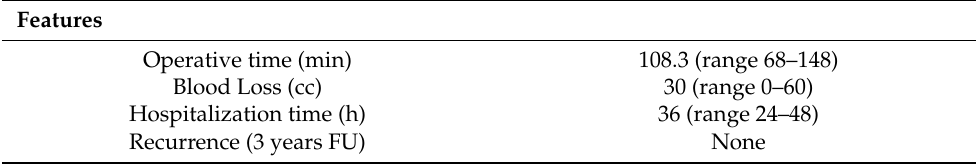
Table 2. Surgical details and post-operative outcome.